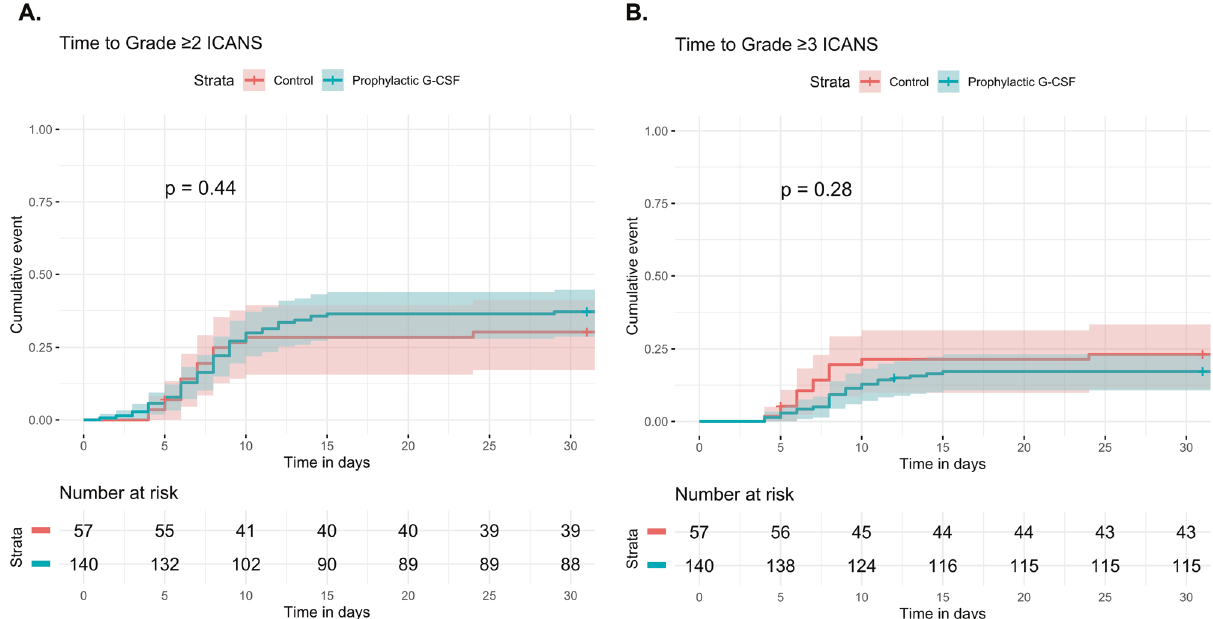
Fig. 3 Cumulative incidence of ICANS in lymphoma patients treated with anti-CD19 CAR T cells. Time to grade ≥ 2 ICANS ( A ) and grade ≥ 3 ICANS ( B ) were estimated. Patients were strati fi ed by whether they received prophylactic G-CSF ( N = 140) or not (control, N = 57), and compared using the method of Gray. There was no signi fi cant difference in the cumulative incidence of grade ≥ 2 and grade 3 ICANS between the prophylactic G-CSF and control groups, including in a multivariate analysis (see Table 5). 95% con fi dence intervals are represented by model for time to grade ≥ 2 CRS was generated. In univariate analysis, CAR T construct, platelets, LDH, and prophylactic G-CSF were signi fi cantly associated with increased risk of grade ≥ 2 CRS (Table 4). In a multivariate analysis that included prophylactic G- CSF, CAR T construct, bridging therapy, ANC, platelets, and LDH, axicabtagene ciloleucel were also analyzed separately. Again,